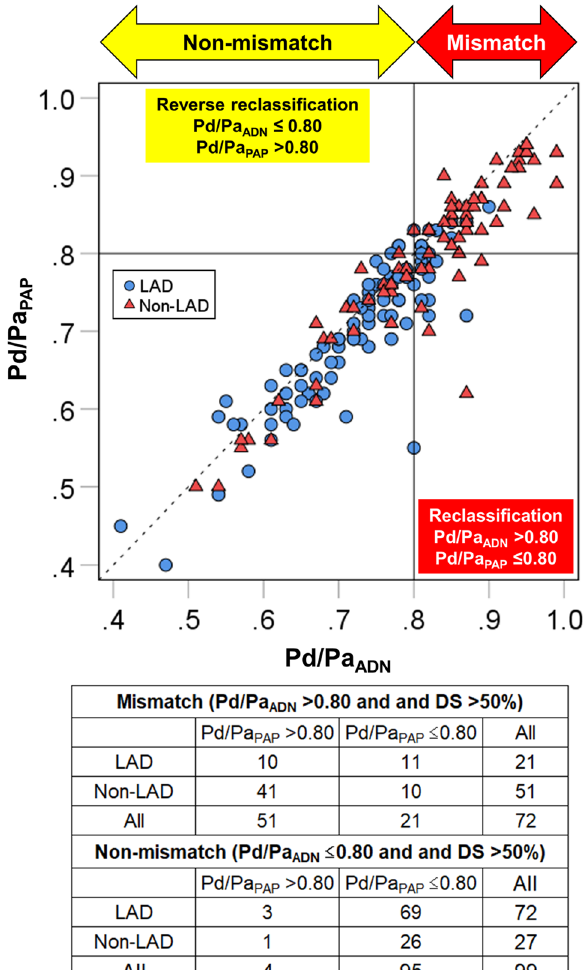
Figure 3. Scatter plot of Pd/Pa ADN and Pd/Pa PAP in vessels with a diameter stenosis of > 50%. The dashed line indicates the line of identity. LAD left anterior descending artery, Pd/Pa ADN distal-to-aortic pressure ratio associated with adenosine, and Pd/Pa ADN distal-to-aortic pressure ratio associated with